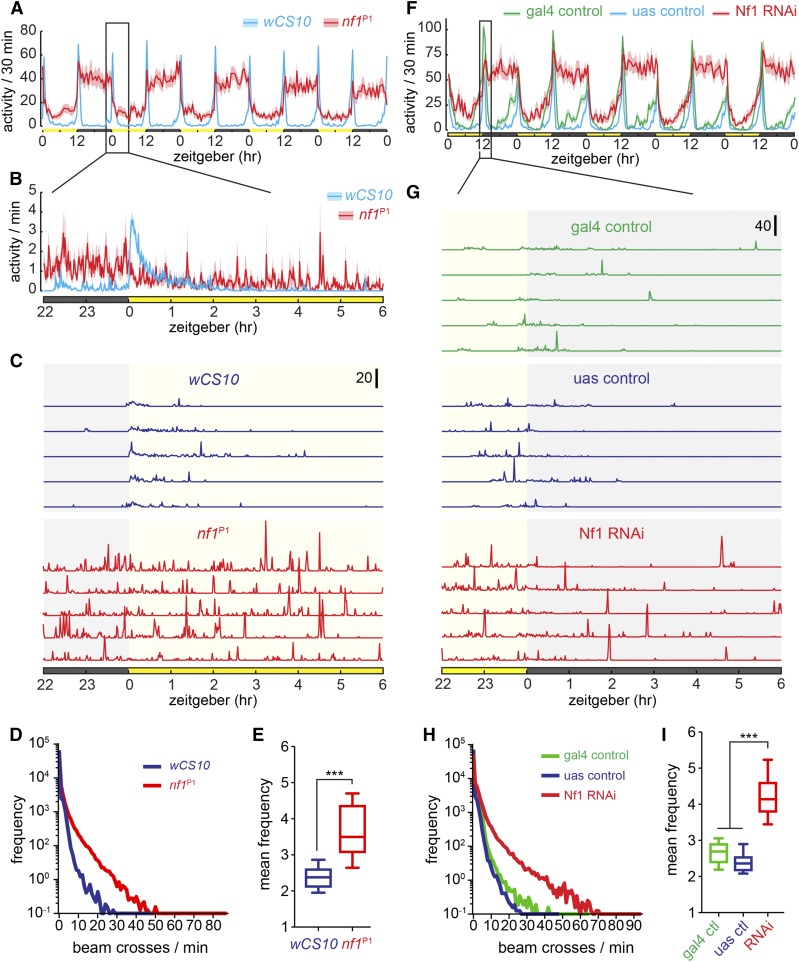
Increased activity with Nf1 loss of function occurs in concentrated bursts of high-frequency activity, as measured by infrared activity monitors. (A) Activity of nf1P1 mutants and wCS10, in units of beam counts per 30 min. Lines and shading represent mean ± SEM. Data are from the same flies as in Figure 1. (B) Expanded view of an 8 hr time segment of the data shown in (A), in units of beam crossings per 1 min. Lines and shading represent mean ± SEM of activity from all flies. (C) Representative examples of activity traces from individual flies sampled from the group data in (B). The y-axis scale bar indicates 20 beam crossings per 1 min. (D) Histogram of activity across flies. Note the log scale. (E) Mean frequency (mean of nonzero values recorded by the infrared activity monitor). *** P < 0.001 (Student’s t-test). (F) Activity of Nf1 RNAi lines and controls, in units of beam counts per 30 min. Data are from the same flies as in Figure 1. (G) Representative examples of activity traces from individual flies sampled from the data in (F). The y-axis scale bar indicates 40 beam crossings per 1 min. (H) Histogram of activity across flies. Note the log scale. (I) Mean frequency (mean of nonzero values recorded by the infrared activity monitor). *** P < 0.001 (Kruskal-Wallis/Dunn).